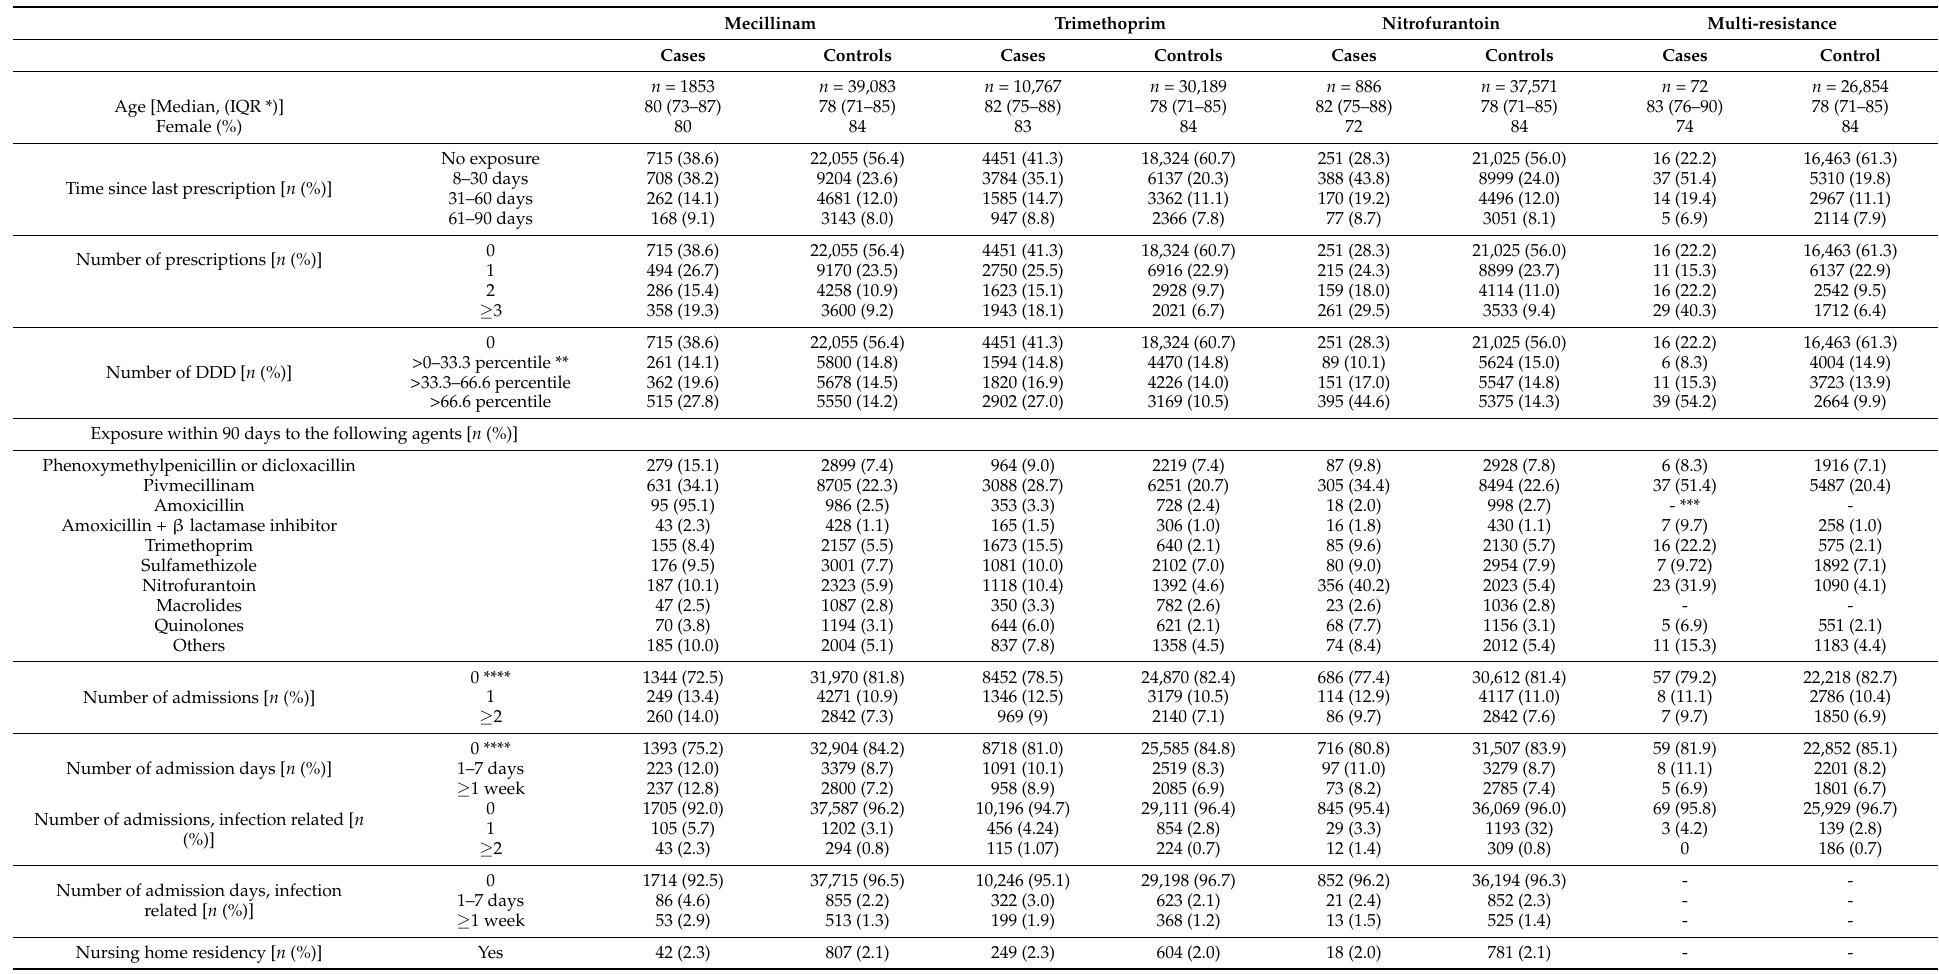
Table 1. Baseline